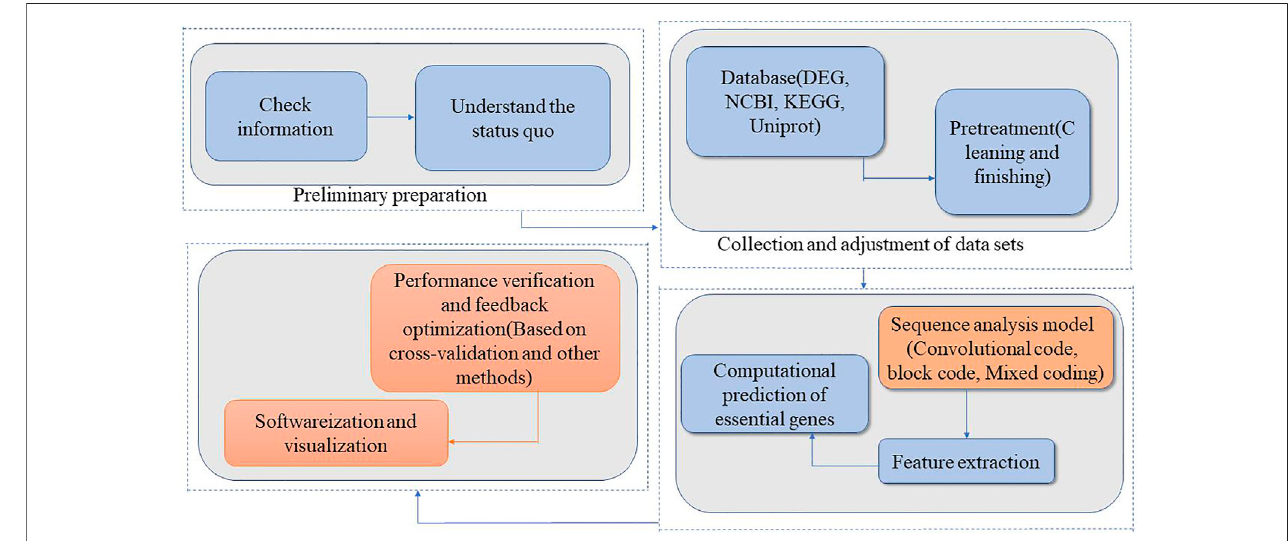
FIGURE 1 | Technical roadmap of gene computational prediction model based on communication coding theory.